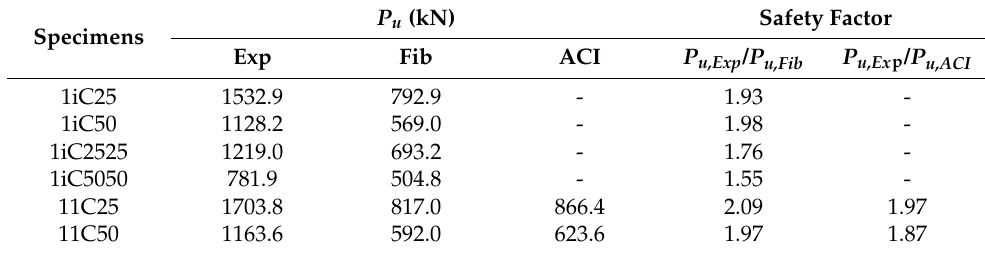
Table 5. Comparison of experimental results vs. design